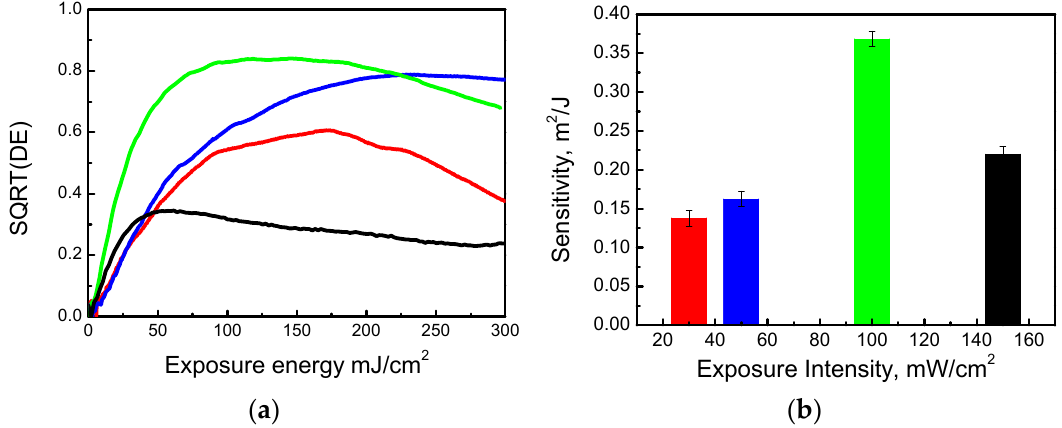
Figure 10. Characterization of the sensitivity of the layers of 70 μ m thickness for recording at 800 linepairs/mm at different recording intensities: ( a ) √η versus exposure energy; ( b ) sensitivity depending on the recording intensity.